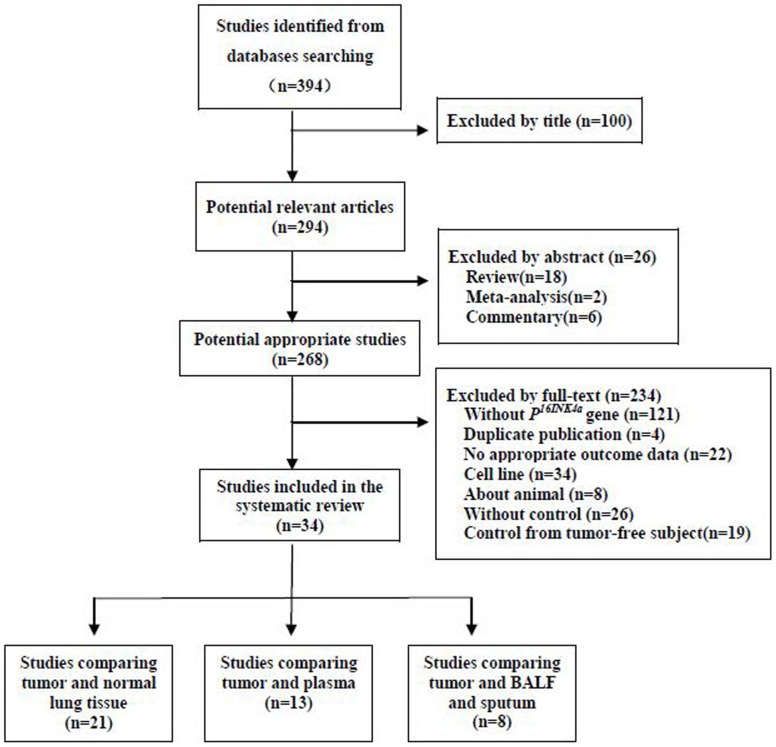
PRISMA flowchart of the literature search strategy for systematic review.(Data from some studies was used more than once, as they reported data in multiple controls.).